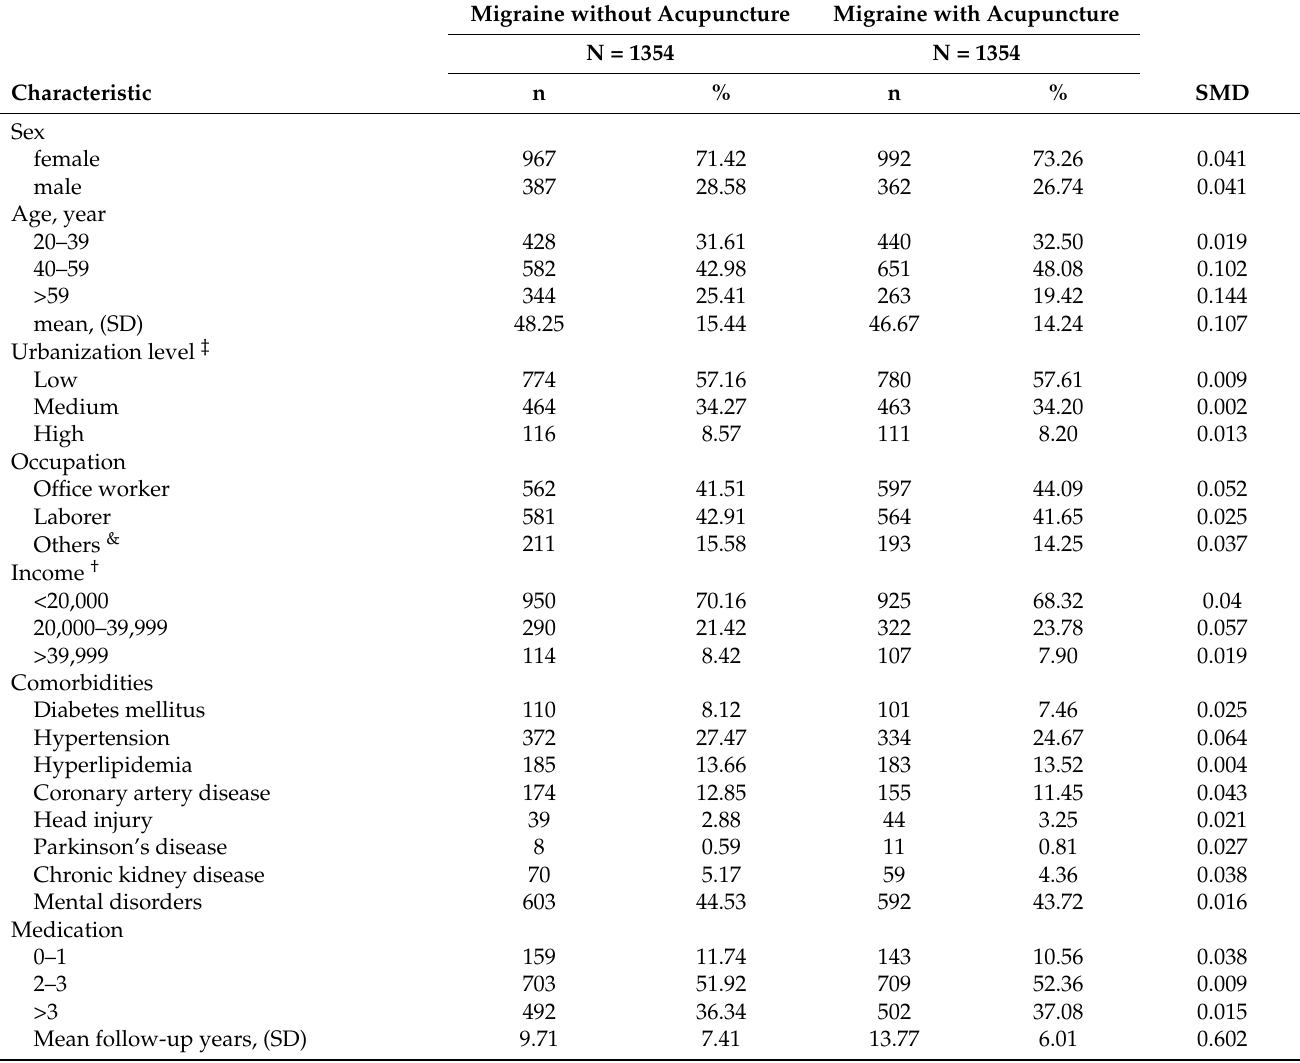
Table 1. Characteristics of new migraine patients who did or did not receive acupuncture. Migraine without Acupuncture Migraine with Acupuncture N = 1354 N =